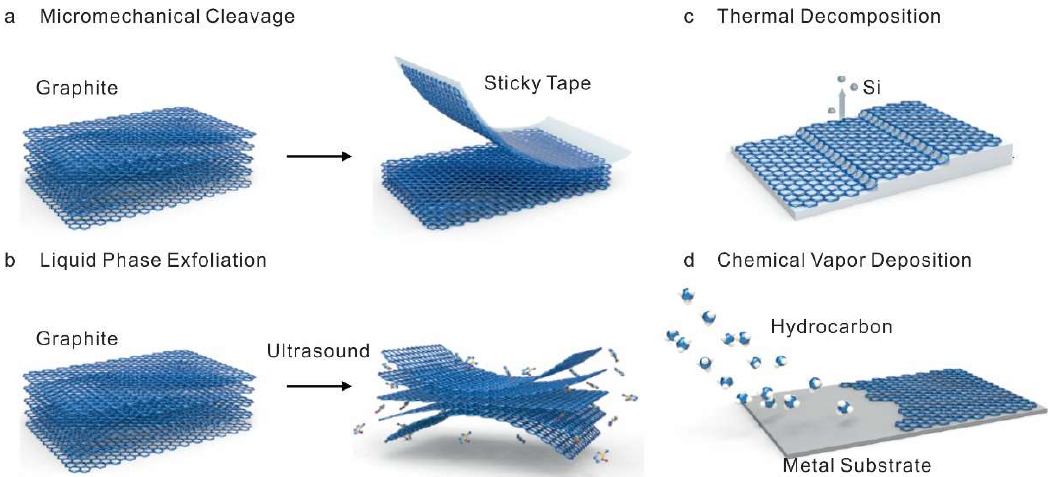
Figure 1. Schematic illustration of the graphene and its derivatives synthesis methods. ( a ) Mechanical exfoliation ( b ) liquid phase exfoliation, ( c ) thermal decomposition, and ( d ) chemical vapor deposition. Reproduced with permission from [23], Copyright Springer Nature, 2017.